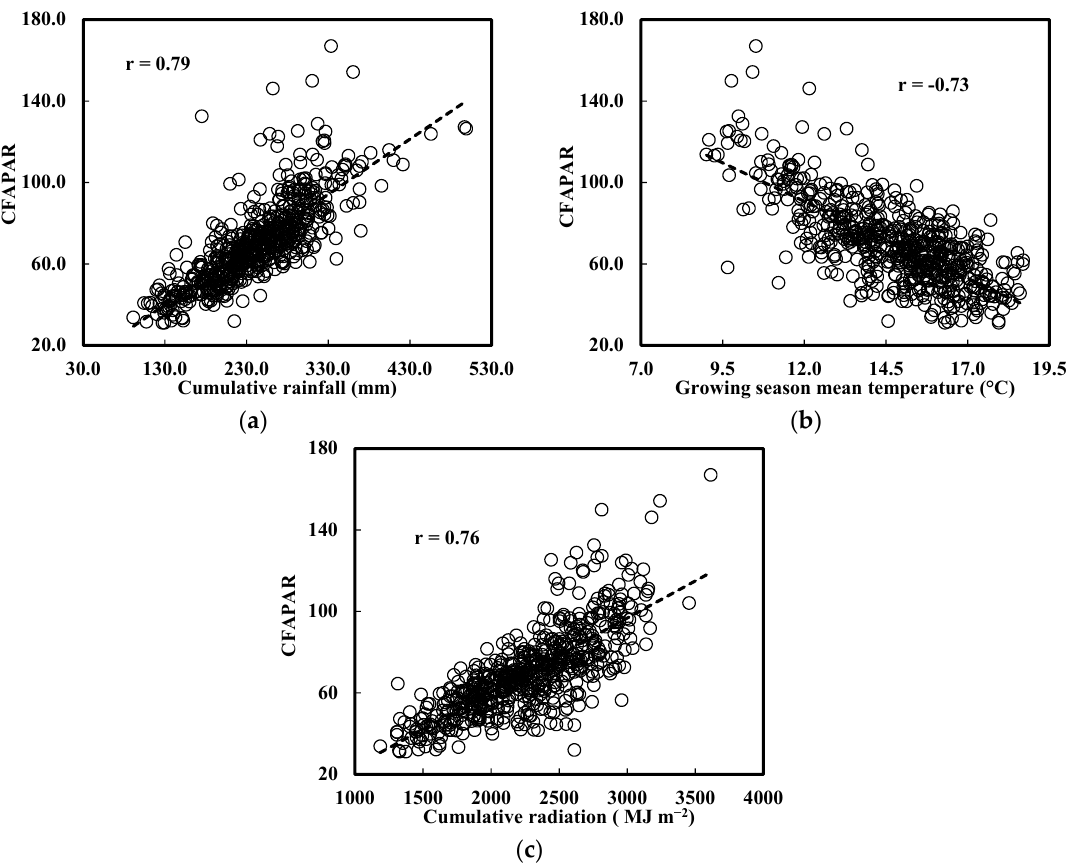
Figure 5. The overall relationship between average annual CFAPAR and average annual cumulative rainfall ( a ); growing season mean temperature ( b ); and average annual cumulative short wave radiation during 2000–2013 ( c ). Samples located inside cropland mask were randomly selected using the Create Random Points tool of ArcGIS software. Table 1. Partial Correlation Matrix, a partial correlation analysis was conducted between average annual CFAPAR and average annual cumulative rainfall, average annual growing season mean temperature and average annual cumulative short wave radiation during 2000–2013. The dataset is shown in Figure 5. CFAPAR CFAPAR Rainfall Temperature CFAPAR ´ 1.00 0.00 Rainfall ´